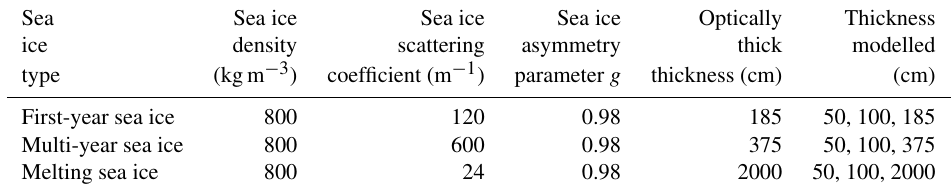
Table 1. Sea ice parameters used as input parameters for the PlanarRad model, based on literature values and detailed in the work of Lamare et al.